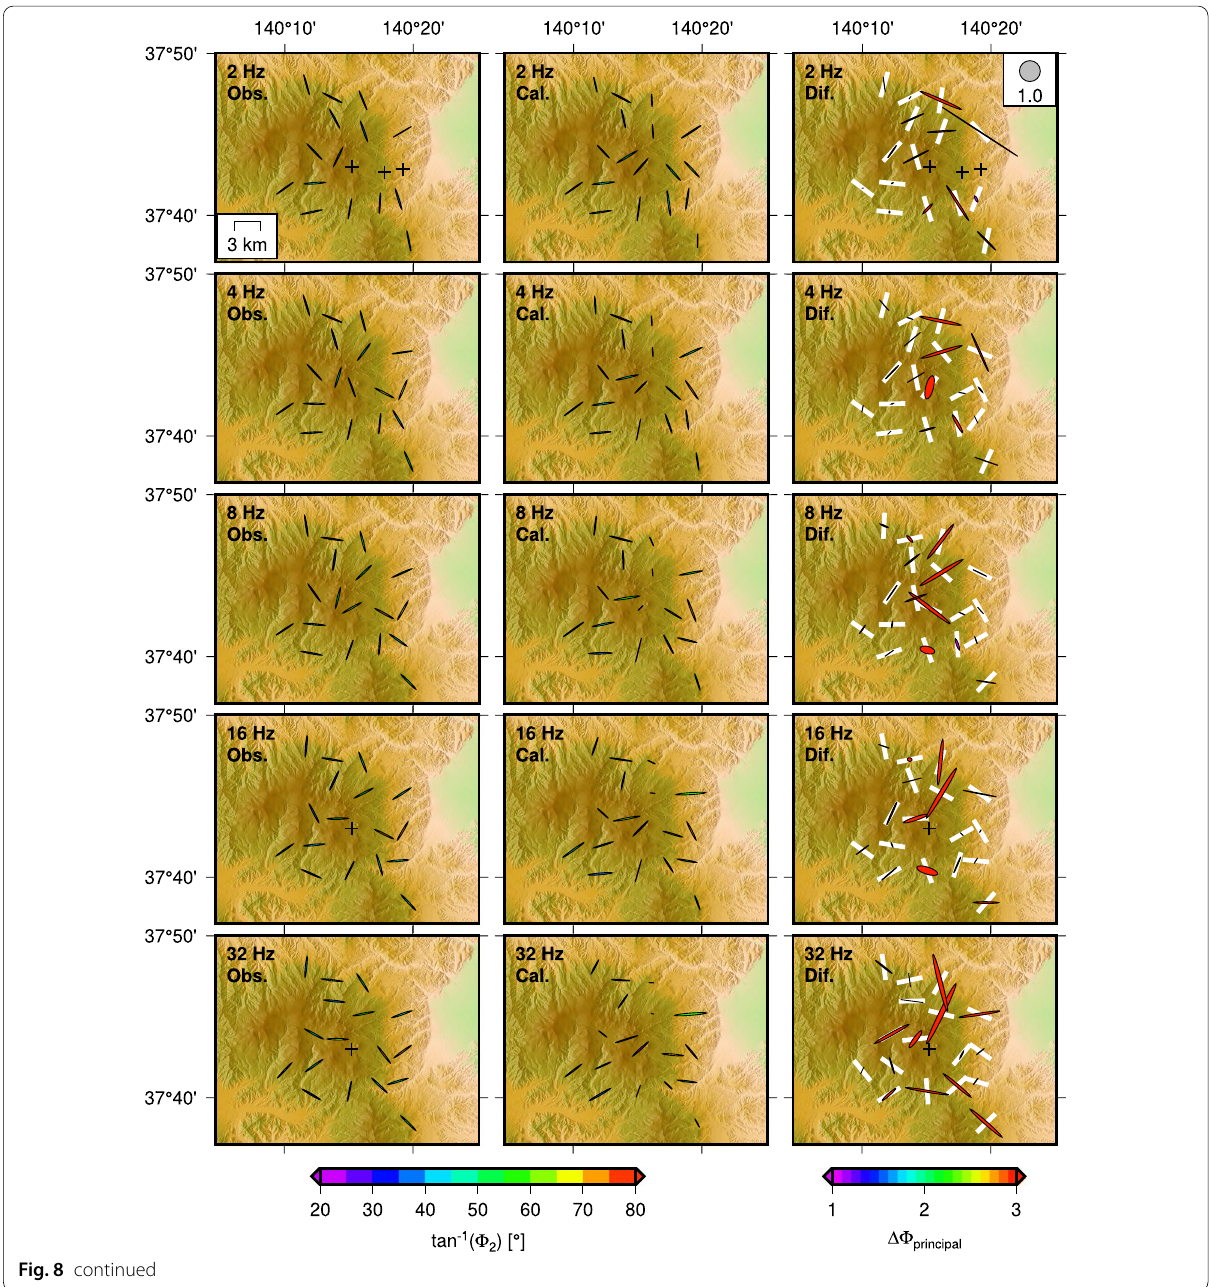
iteration 8 on the first update prior model, 0.032 at itera- tion 5 on the second update, and 10 at iteration 2 on the third update, until we achieve the final model (viz. blue plots in Fig. 3). Here, we fix λ at 0.1 in the CRTs. Figure 10 shows the result of CRTs using checkerboxes with dimensions of about 3 km to a side. Outputs using each prior model show blurred checkerboxes, and the number of conductive checkerboxes cannot be